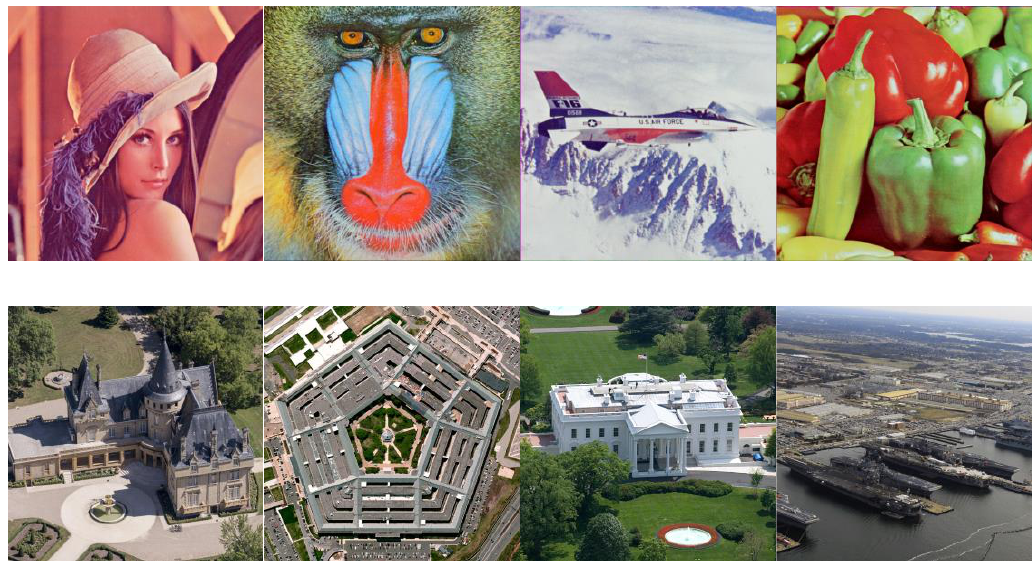
Figure 14. Watermarked images.